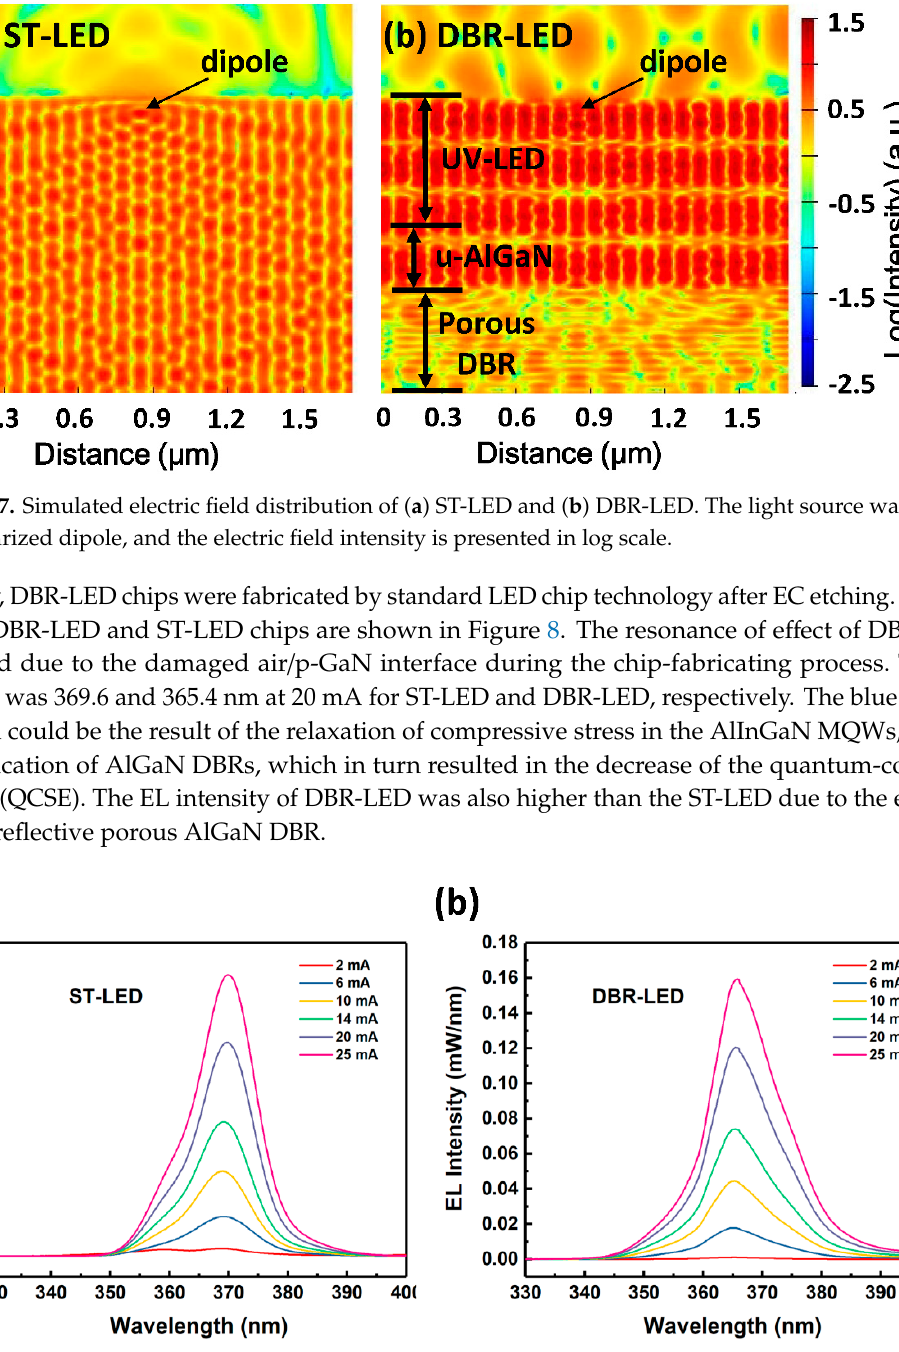
Figure 8. EL spectra of ( a ) ST-LED; and ( b ) DBR-LED at the current from 2 to 25 mA.